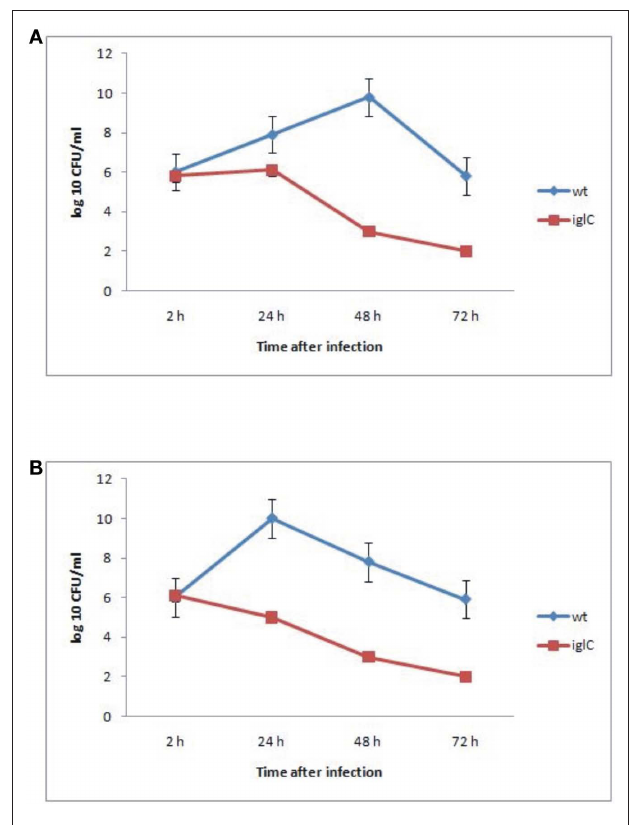
Figure 1 | intracellular growth of F. novicida and its isogenic mutant iglC in A. castellanii (A) and in H. vermiformis (B) . The cells were infected for 15 min, followed by gentamicin treatment, and determination of the number of intracellular bacteria at the indicated time points. The error bars represent standard deviations of triplicate samples and results shown are representative of three independent